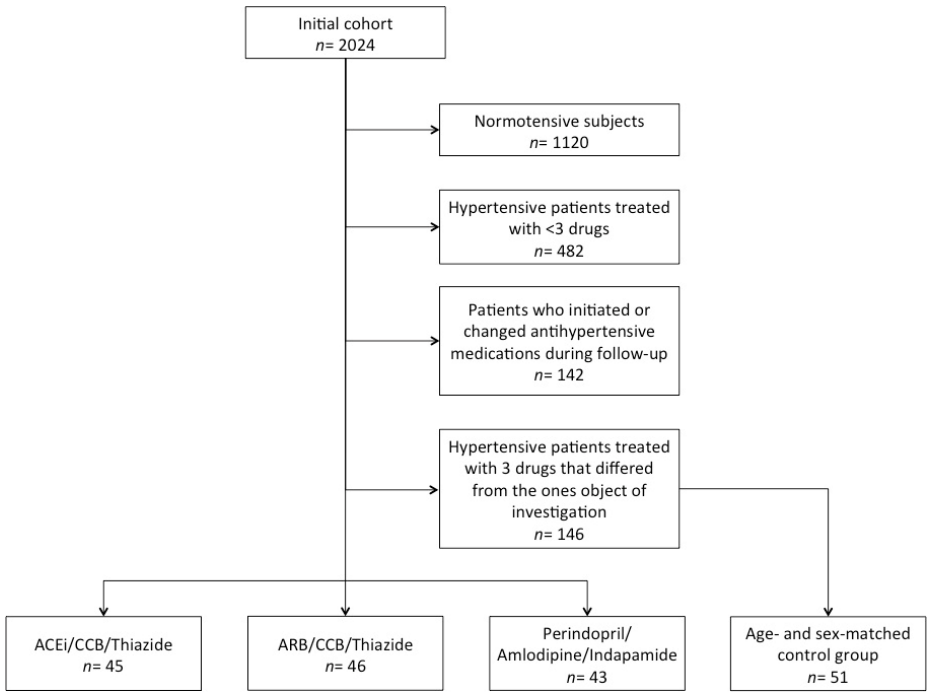
Figure 1. Flow-chart resuming the selection criteria applied to the full BHS cohort to select the sub-cohort.